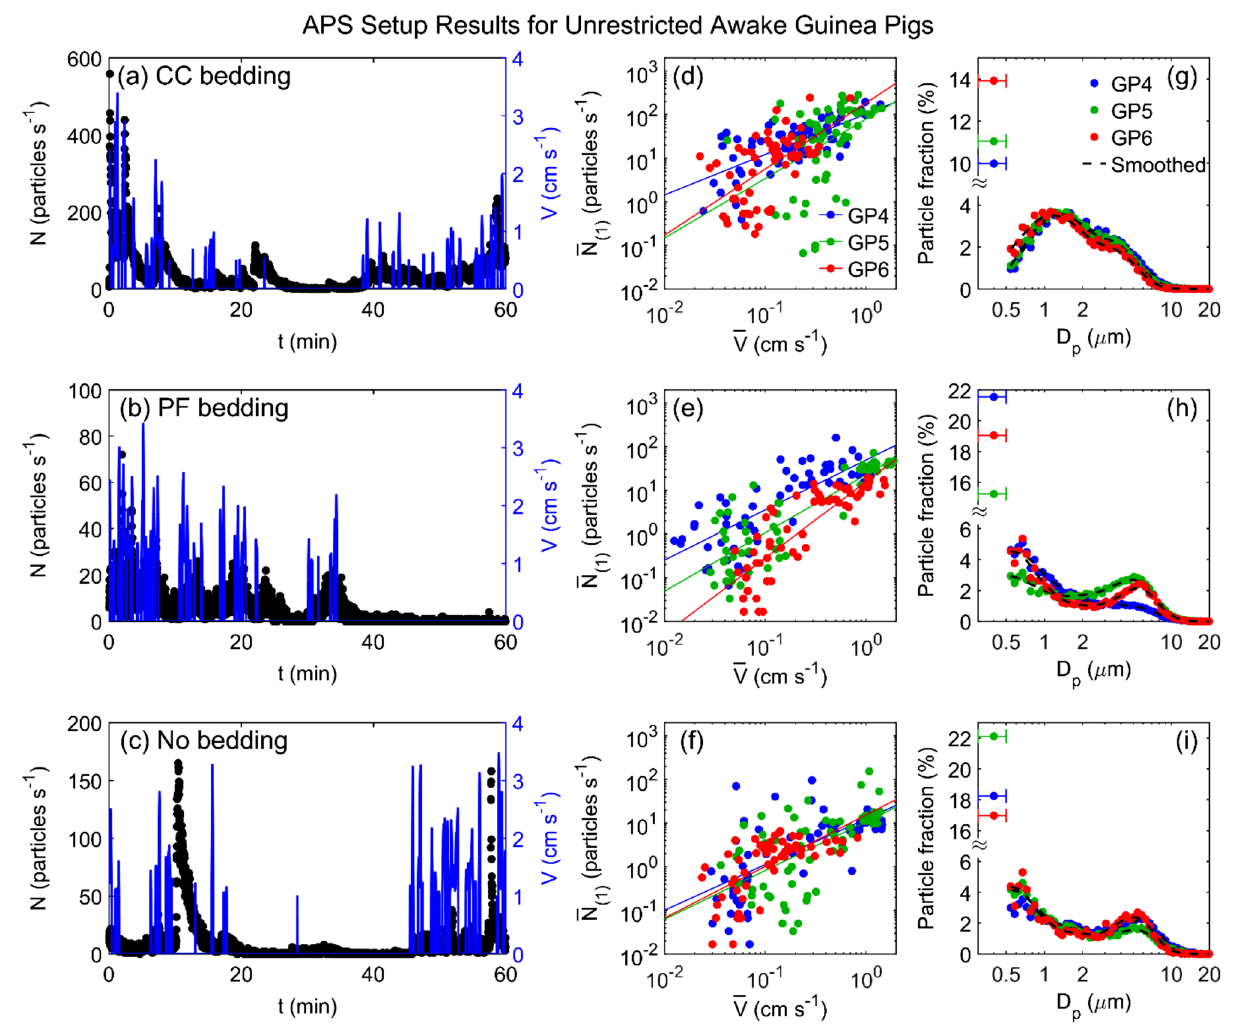
Figure 3. Particle emission rates measured by APS setup for unrestricted awake guinea pigs. Particle emission rate, N (left axis) and guinea pig movement velocity, V (right axis) versus time for a representative guinea pig in the cage with ( a ) CC bedding, ( b ) PF bedding, and ( c ) no bedding. Time-averaged particle emission rate, N ( 1 ) versus time-averaged guinea pig movement velocity, V ( 1 ) , for three uninfected awake guinea pigs (GP4, GP5, and GP6) in the cage with ( d ) CC bedding, ( e ) PF bedding, and ( f ) no bedding. Solid lines are power law fits (see Table S2 for statistics). Corresponding size distributions ( g , h , and i ) for the uninfected awake guinea pigs (GP4, GP5, and GP6) in the cage with ( g ) CC bedding, ( h ) PF bedding, and ( i ) no bedding. The left-most data points in each plot shows the fraction of particles counted in the 0.3–0.5 μm bin, which cannot be further size- discriminated. The whiskers represent the width of the bin (0.3–0.5 μm). Dashed lines represent the data using a 5-point smoothing function. Data indicated by blue markers for GP4 in ( d ) and ( g ) are reproduced from Asadi et al. 24 and included here for